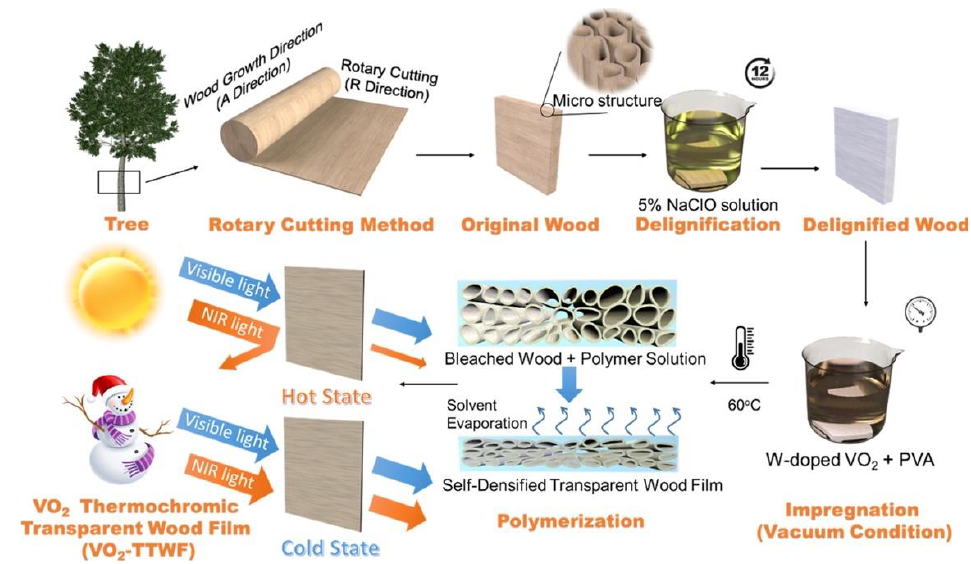
Figure 16. Scheme of the process for obtaining thermochromic transparent wood films containing VO 2 nanoparticles (VO 2 -TTWF). Reprinted with permission from [39], copyright 2021, American Chemical Society.